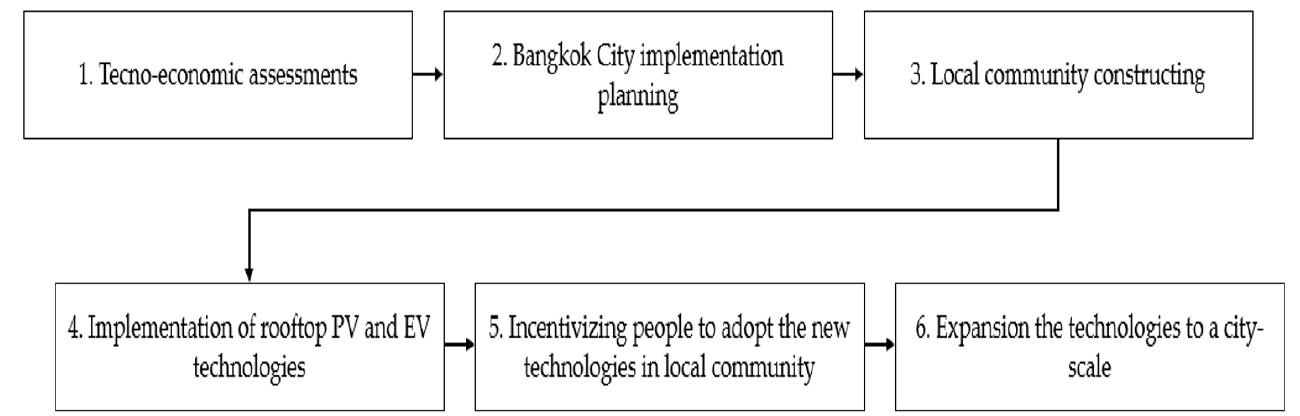
Figure 1. The flowchart shows processes of rooftop PV and EV penetration in Bangkok City (adapted from [14]). 1. Techno-economic assessments are carried out; 2., 3. Bangkok City and local people planning is accelerated for the future design; 4. implementation of new technologies is supported by government incentive policies; 5. the policies incentivize citizens to use EVs and rooftop PV; 6. new technologies are expanded to the city scale.